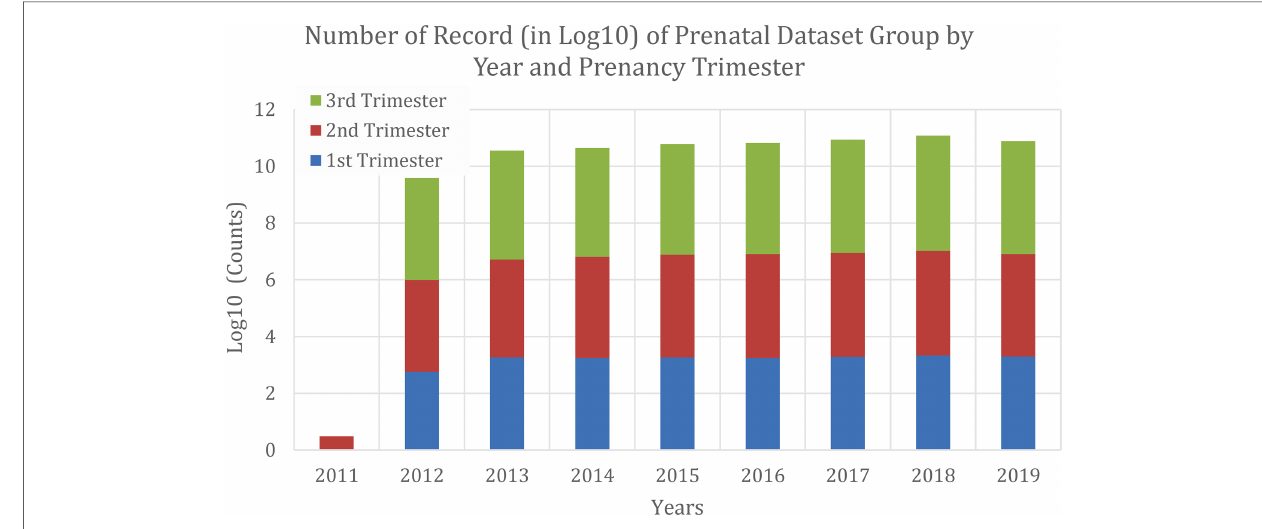
FIGURE 1 Data distribution from Apr 2011 to May 2020 that was used to generate local fetal growth chart curves.